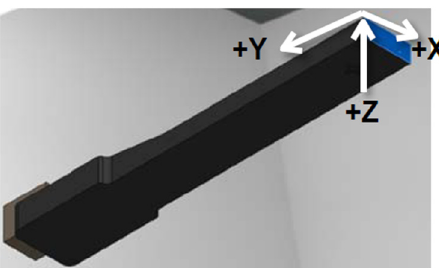
Figure 2: SpinMeter - 3D sensor [ 9 ] .